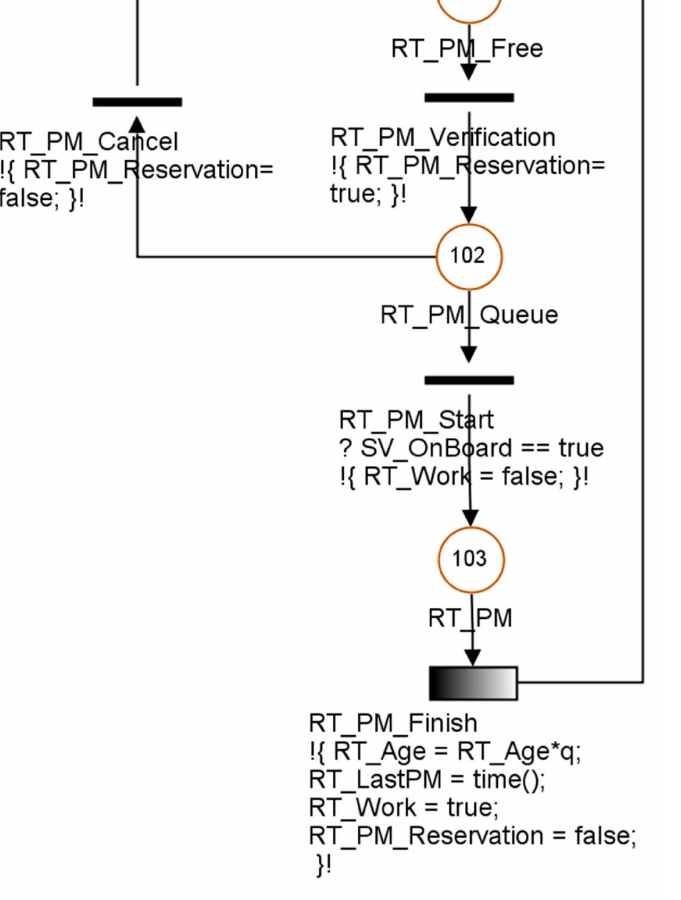
Figure 4. PN model of PM activity